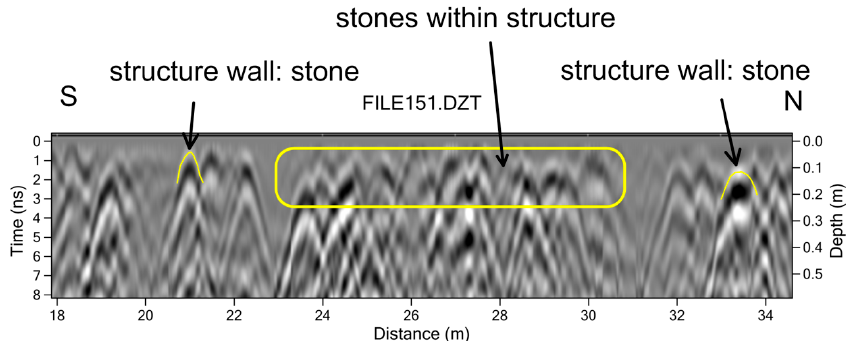
Figure 4. Reflection profile showing the upper 50 cm of ground with some of the near-surface stones that define the walls of the structure noted, but many other stones that are randomly located.